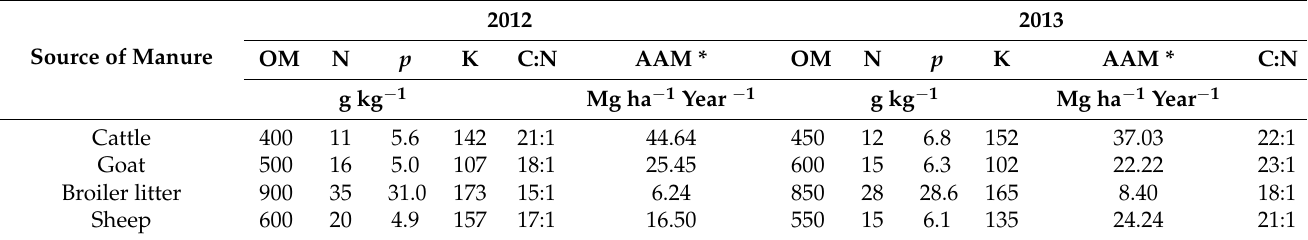
Table 2. Chemical characteristics and the amount applied from different sources of